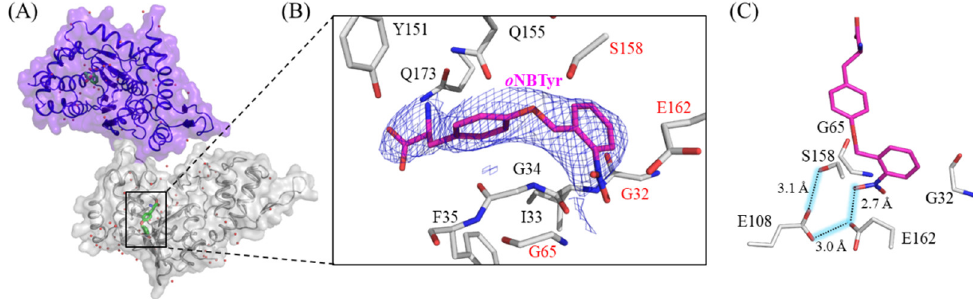
Figure 1. The crystal structure of M. jannaschii o NBTyrRS (Y32G, L65G, F108E, D158S, L162E, and D286R) complexed with o NBTyr. ( A ) Dimeric structure of M. jannaschii o NBTyrRS bound to o NBTyr in the asymmetric unit. The substrate o NBTyr and water molecules are shown by green sticks and red spheres. ( B ) Close-up view of o NBTyr. The |2F o − F c | electron density map (contoured at 1.0 σ, blue mesh) corresponds to o NBTyr in the amino-acid binding site of o NBTyrRS. Mutated residues are indicated by the red letters. ( C ) Hydrogen-bonding interactions to recognize the o -nitrobenzyl group by o NBTyrRS. Numbers indicate the distance (Å) between two atoms connected by dashed lines.